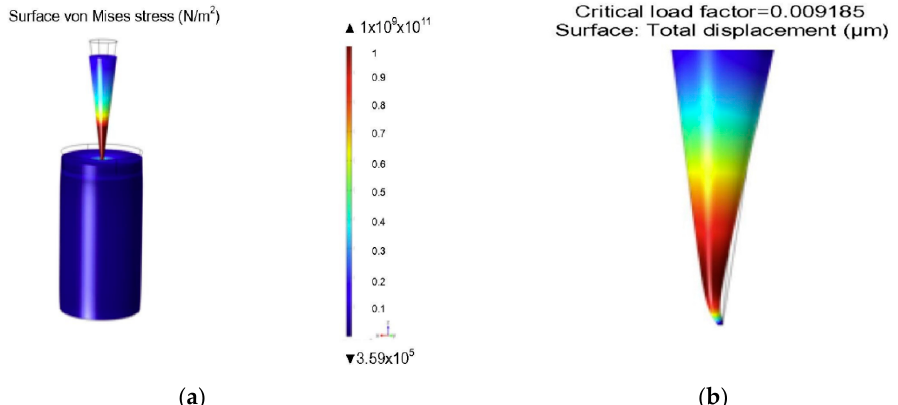
Figure 12. A numerical mesh used for finite element method (FEM) modelling of MN design (adopted from [90]).